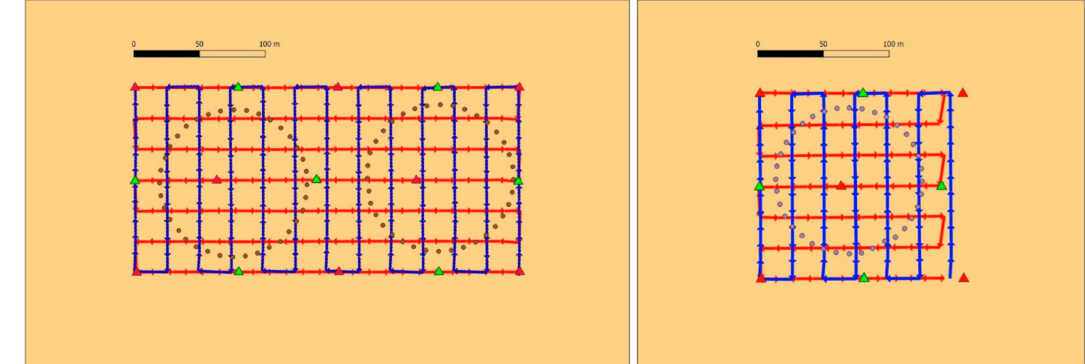
Figure 2. The surveyed area (orange background) with the trajectories of the three strip types: Longitudinal (blue); Cross (red); POI (brown). The figure depicts a Control type GCP with Enhanced control tightness (see Table 3) where GCP are represented by triangles. Different colours of triangles refer to control tightness: Basic (red) or Enhanced (red + green). ( Left ): LCO block configuration. ( Right ): HLCO block